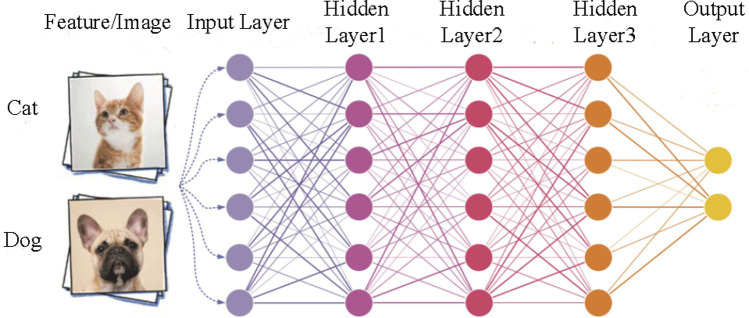
Overall framework of tourism service recommendation model based on Internet information technology and deep learning.